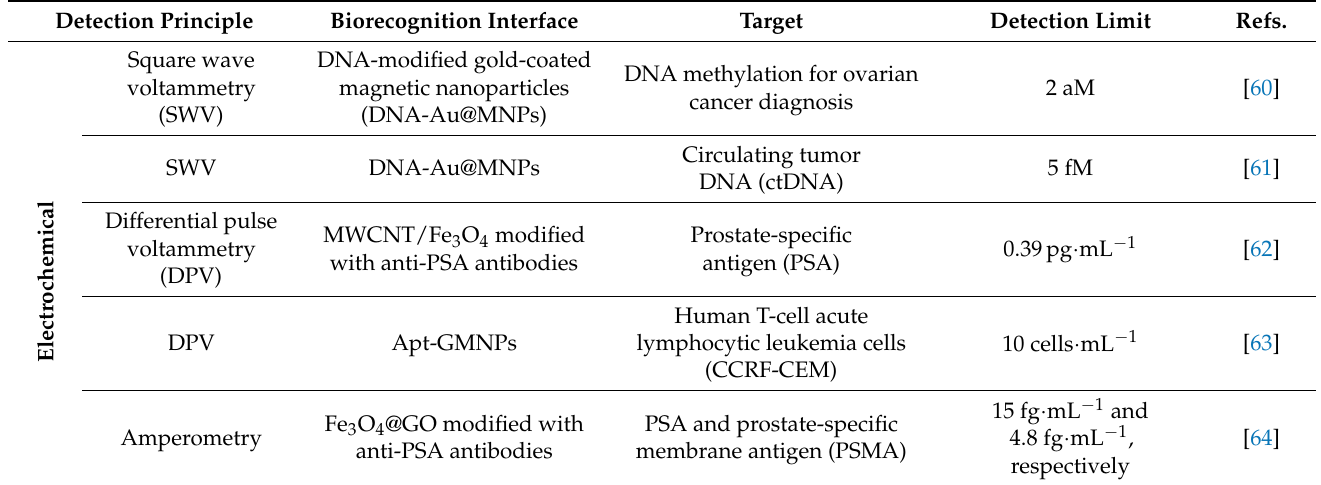
Table 1. Applications of synthetic magnetic nanoparticles in biosensors for cancer